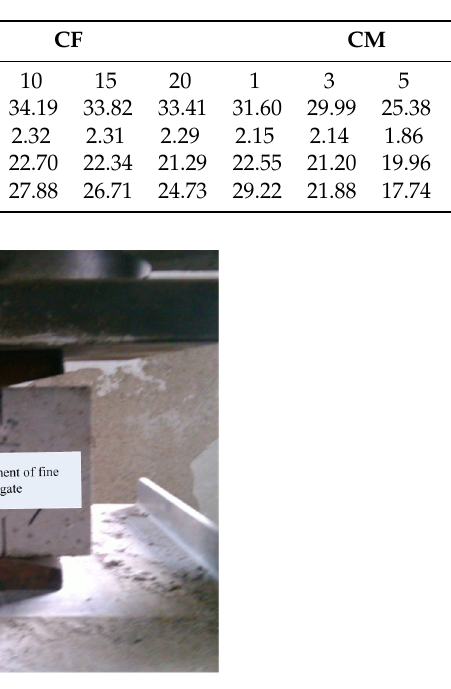
Table 2. Mechanical properties of crumb rubber concrete.